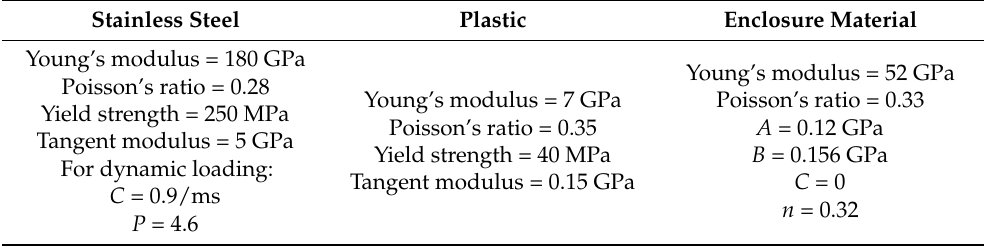
Table 3. Material properties used for stainless steel, plastic, and aluminum-based enclosure